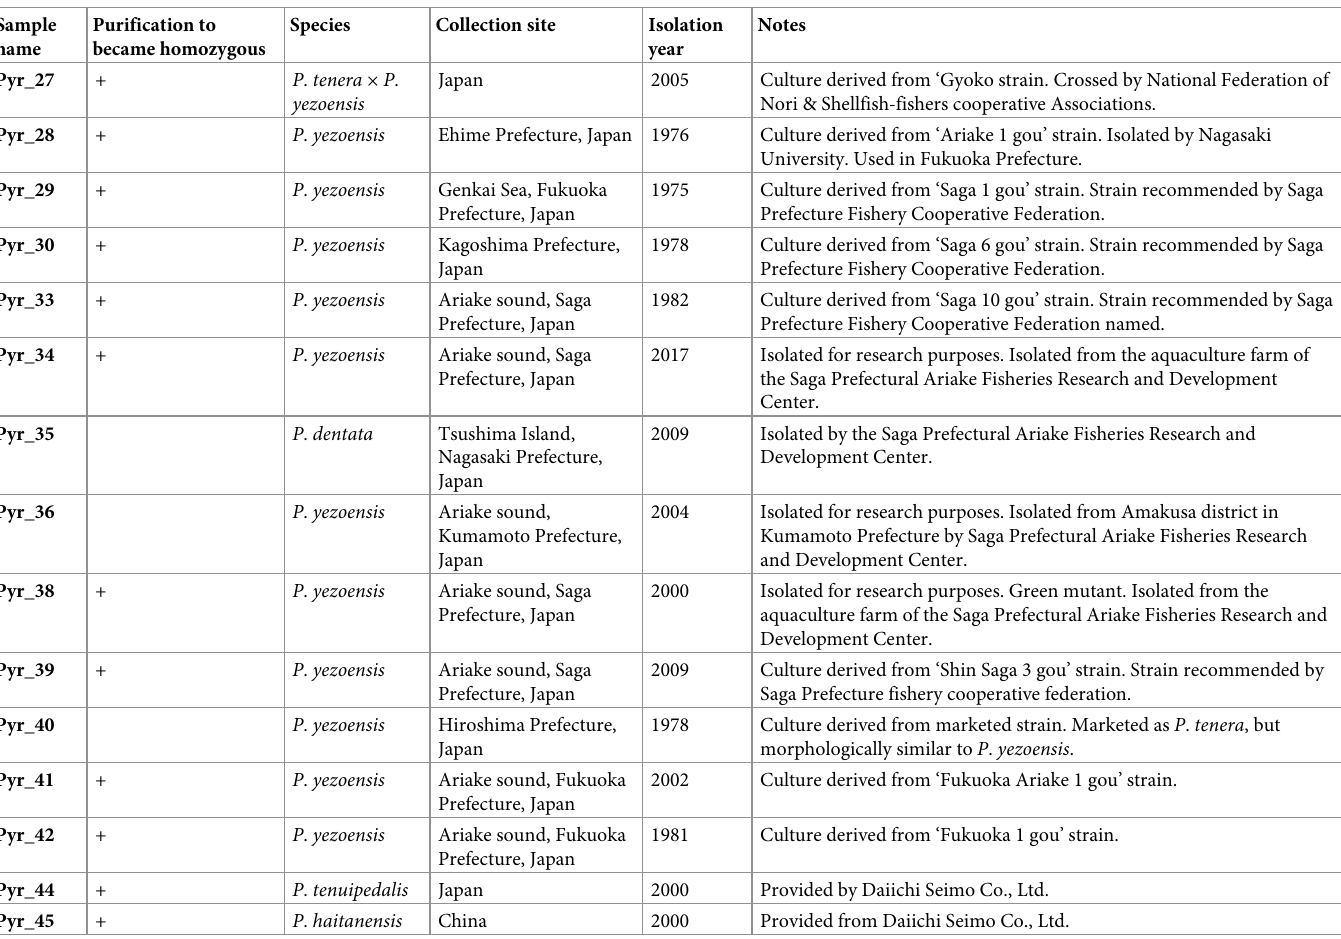
by 1% agarose gel electrophoresis. The concentration of DNA was determined by Qubit dsDNA BR Assay Kit (Thermo Fisher, Foster City, CA,